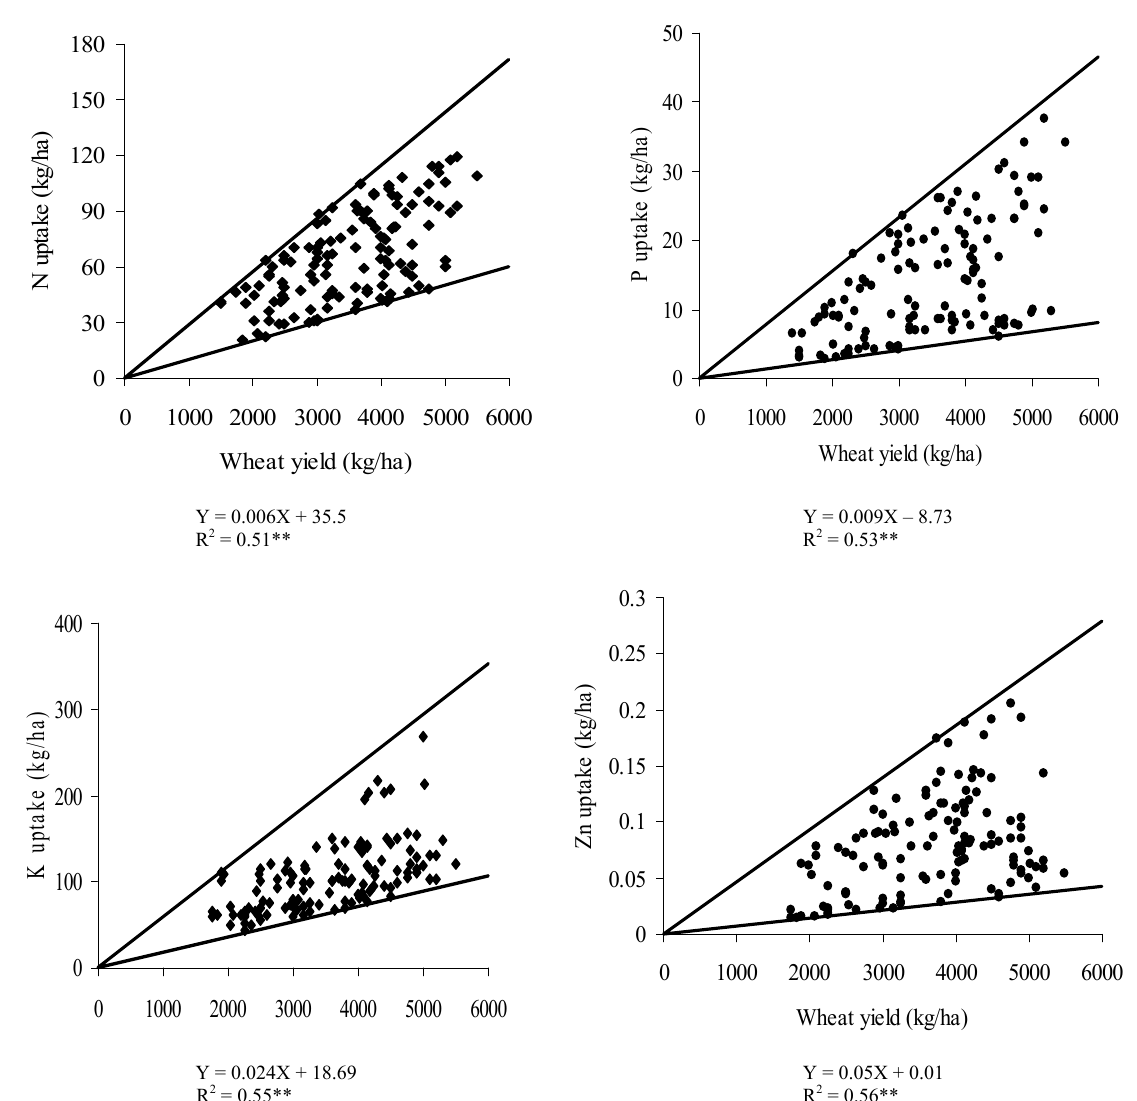
FIGURE 2. Relationship between grain yield of wheat and plant nutrients of N, P, K, and Zn. The upper and lower lines indicate yields with maximum dilution and maximum accumulation, respectively, by taking upper and lower 10 th percentile as outliers. Although 10% of the total data lie outside the lines, they were not shown in the figure as they are of less importance. Data are based on experiments conducted at 20 sites in the Nadia district of West Bengal during the years 2001–2002 and 2002–2003.